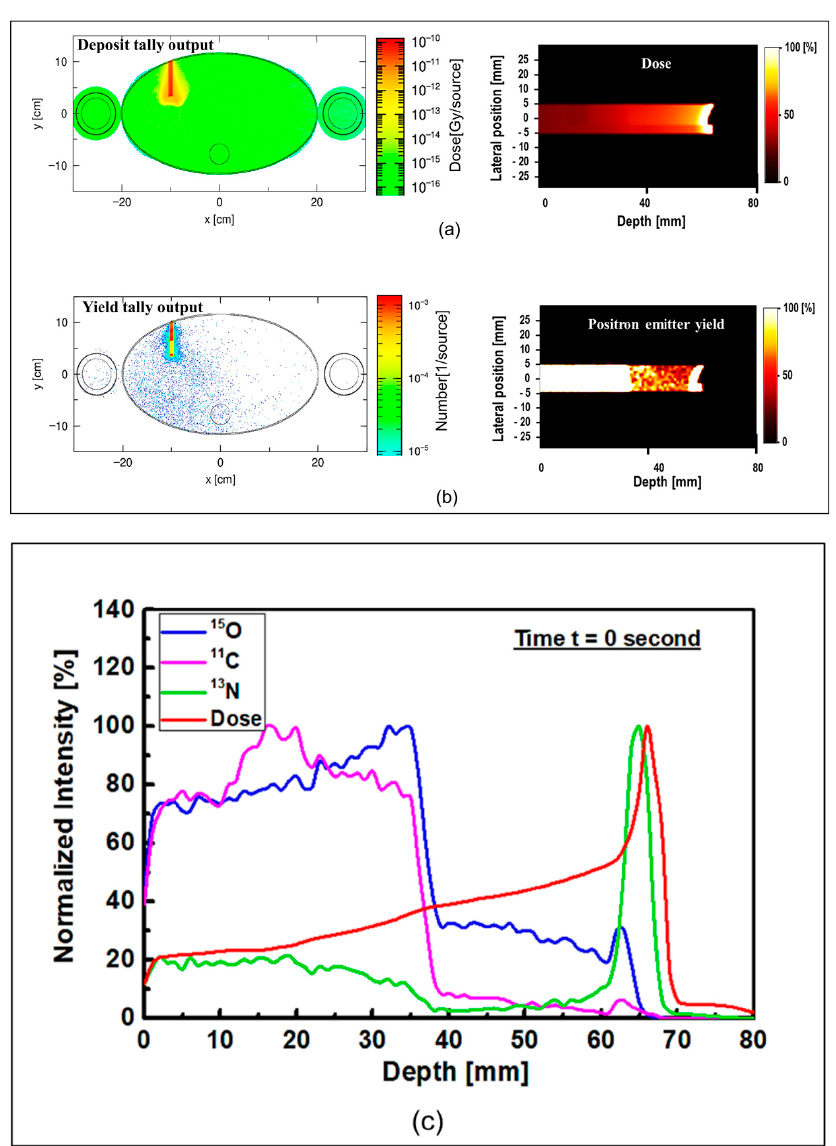
Figure 5. The energy deposition (top-left) and production of positron emitting radionuclides (top- right) obtained in the modelled MIRD anthropomorphic phantom. The 2D distribution of: ( a ) dose deposition of protons; ( b ) distributions of positron emitting radionuclides determined along the inci- dent proton beam track; and ( c ) the distribution of deposited dose and positron emitting radionuclides versus depth in the body of MIRD anthropomorphic